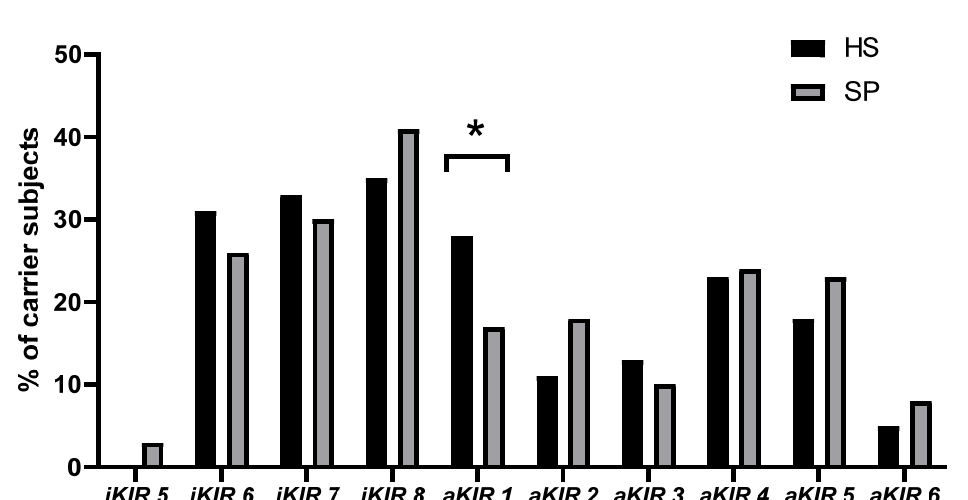
Figure 1. Distribution of inhibitory and activating KIR genes in healthy subjects (HS) and subjects with psoriasis vulgaris (SP). * p = 0.047 based on X 2 and p ’ = 0.282, based on Holm–Bonferroni correction for multiple comparisons.